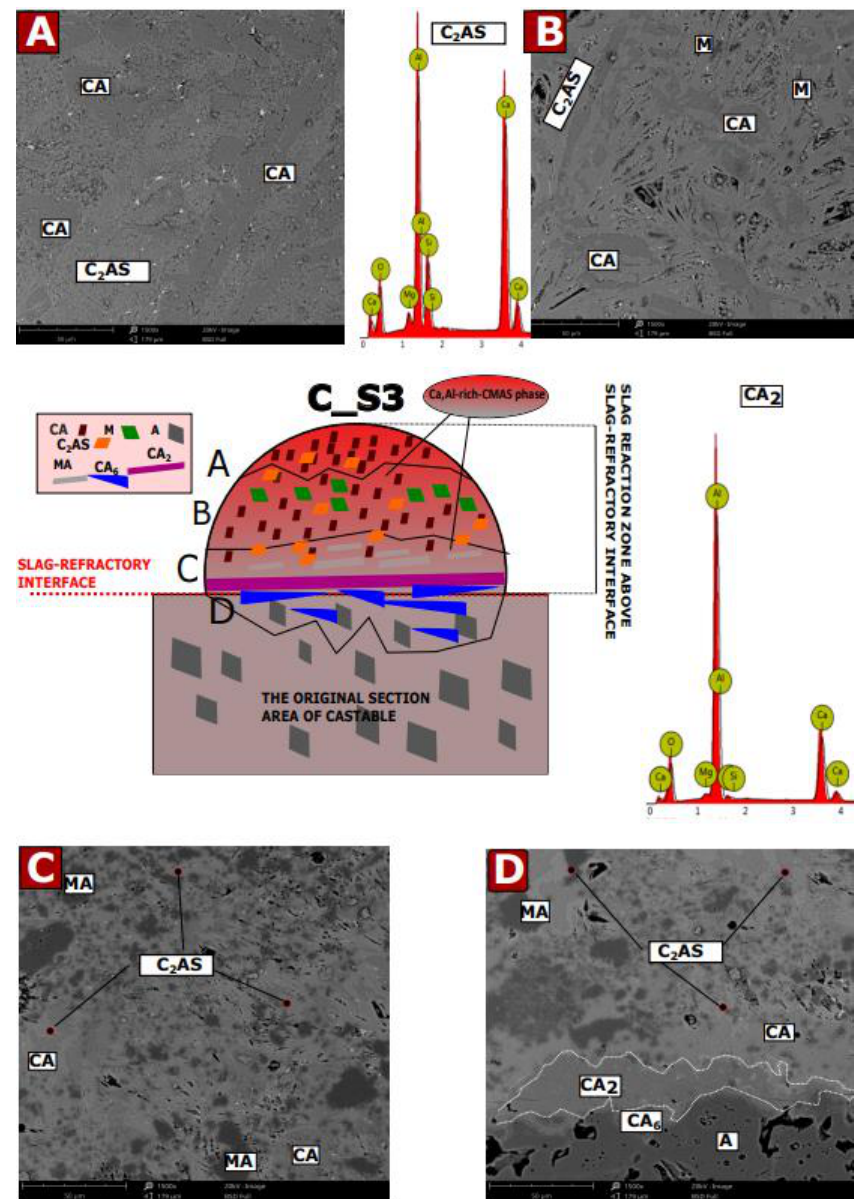
Figure A3. ( A – D ) In the center is a schematic diagram of the phases present in the castables-slag S3 sample after corrosion. In the corners, there are photos of SEM micro-areas, as well as selected EDS.